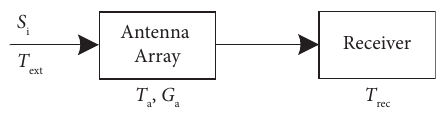
Figure 1: System-level model for receiving